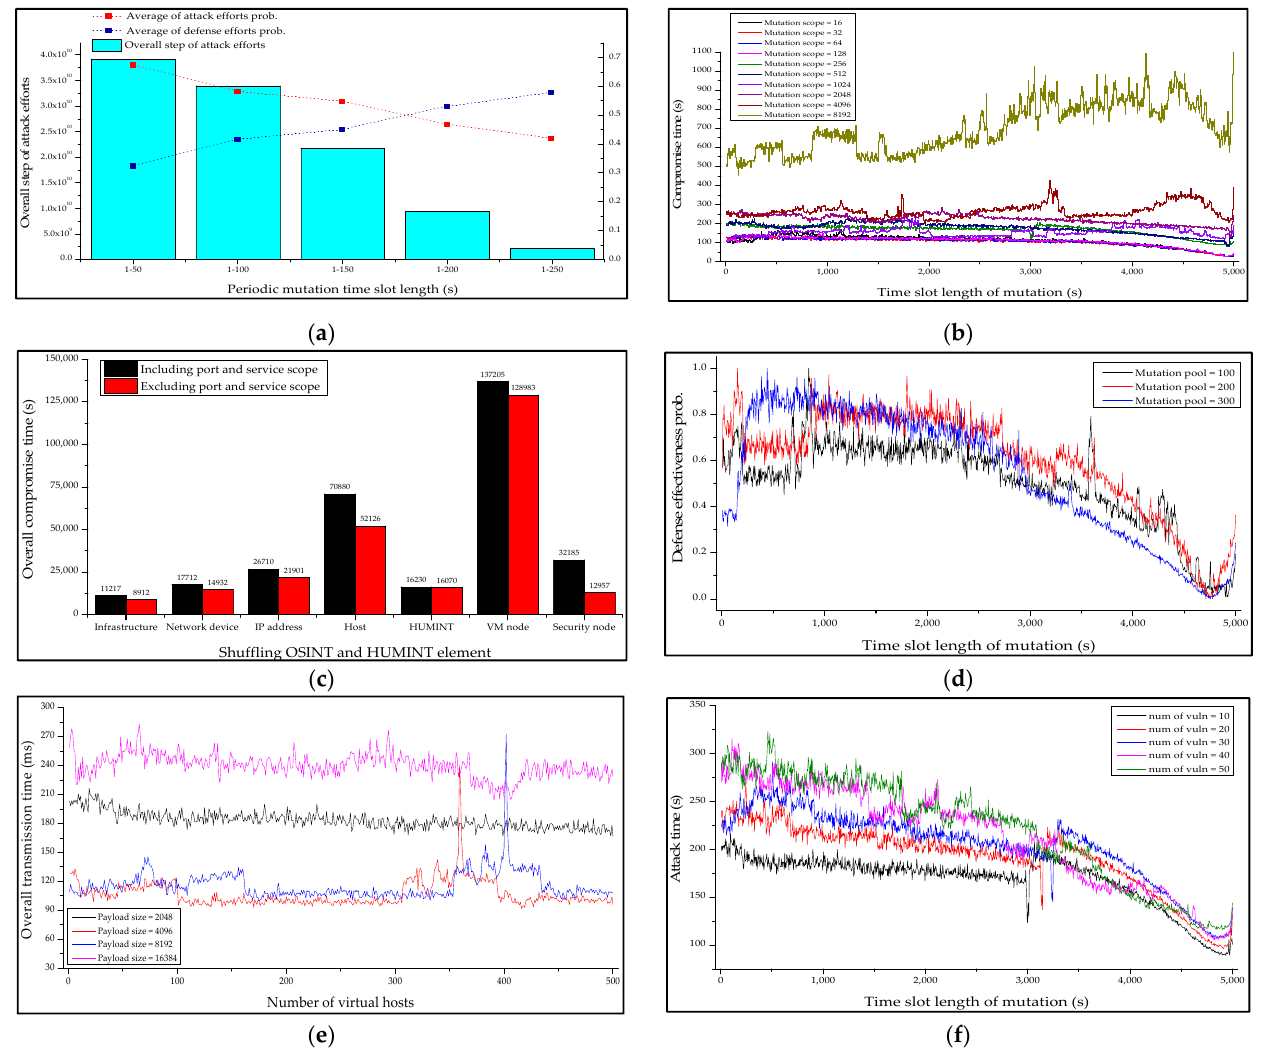
Figure 8. Comparative sensitivity analysis of organizational IODA with optimization of LPC-MTD and HS-Decoy. ( a ) Periodic mutation time slot, ( b ) mutation scope of OSINT and HUMINT, ( c ) mutation port and service scope of OSINT, ( d ) mutation selective batch pool size, ( e ) exploit or dummy packet size in SDN, and ( f ) number of CVE vulnerability.